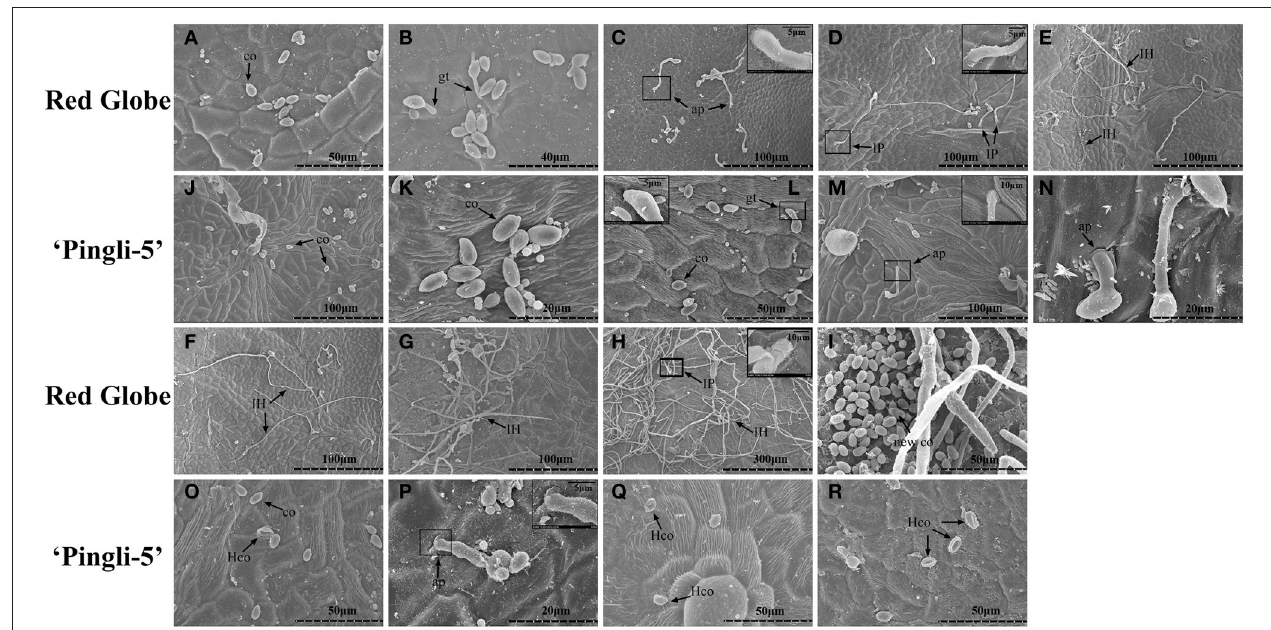
FIGURE 4 | Comparison of B. cinerea conidia development on “Pingli-5” and “Red Globe” leaves using scanning electron microscopy. Progression of B. cinerea colonization on “Red Globe” (A–I) and “Pingli-5” (J–R) . Leaves were harvested 4, 8, 12, 18, 24, 36, 48, 72, and 96h post-inoculation (hpi) and the experiments were repeated three times. Arrows indicate a co, conidium; gt, germ tube; ap, appressorium; IP, infection peg; IH, infection hypha; new co, new conidium; and Hco, hollow conidium. Large black blocks indicate magnifications at the sites of small black blocks. Scale bars: (A,I,L,O,Q,R) : 50 µ m; (B) : 40 µ